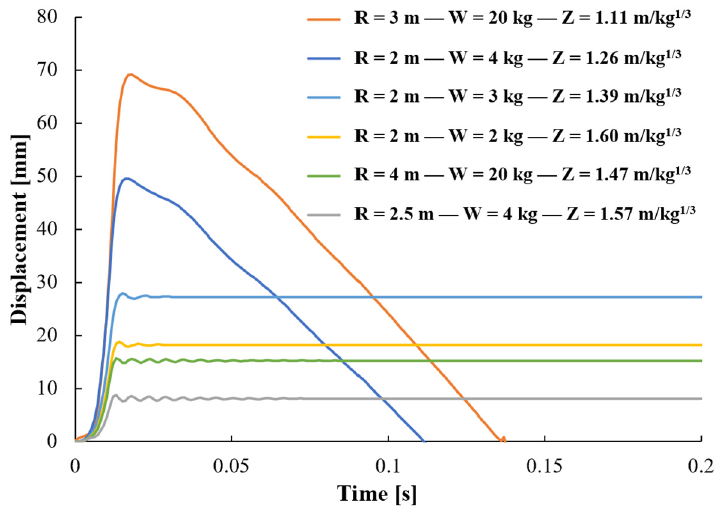
Figure 6. Typical results of a local numerical analysis for demand assessment: time histories of midspan node lateral displacement due to lateral blast load.